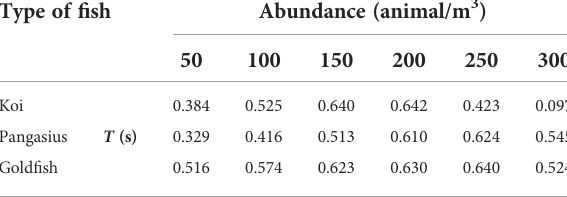
TABLE 2 Integral time scale of the fl ow generated by the selected fi sh schools at various abundances and at a water temperature of 24°C. Type of fi